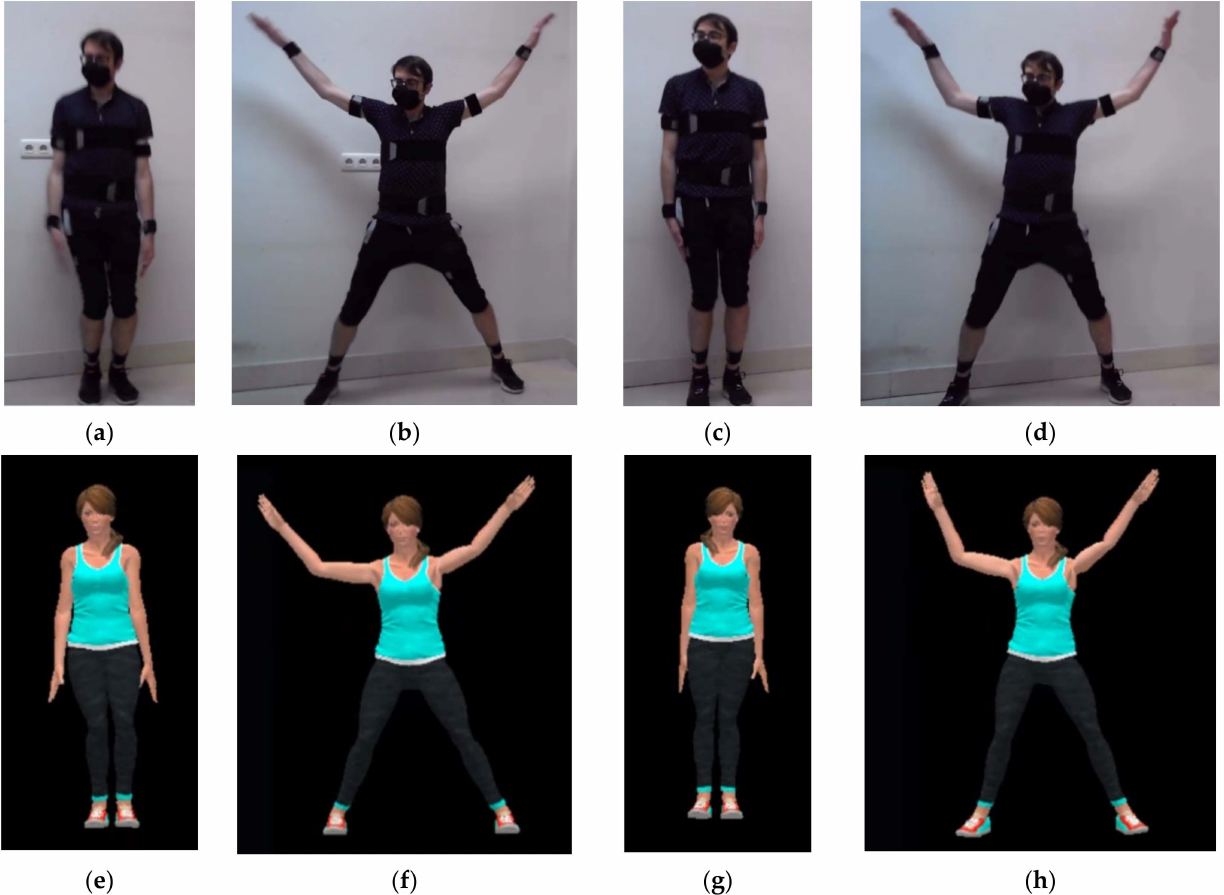
Figure 11. Half jacks movement acquisition with 10 and 12 CW sensors and movement reconstruction on a 3D avatar: ( a ) Initial stance with 10 CW; ( b ) Maximum Range Of Movement (ROM) position with 10 CW ( c ) Initial stance with 12 CW; ( d ) Maximum ROM with 12 CW; ( e ) Initial stance with 10 CW; ( f ) Maximum ROM position with 10 CW; ( g ) Initial stance with 10 CW; ( h ) Maximum ROM position with 12